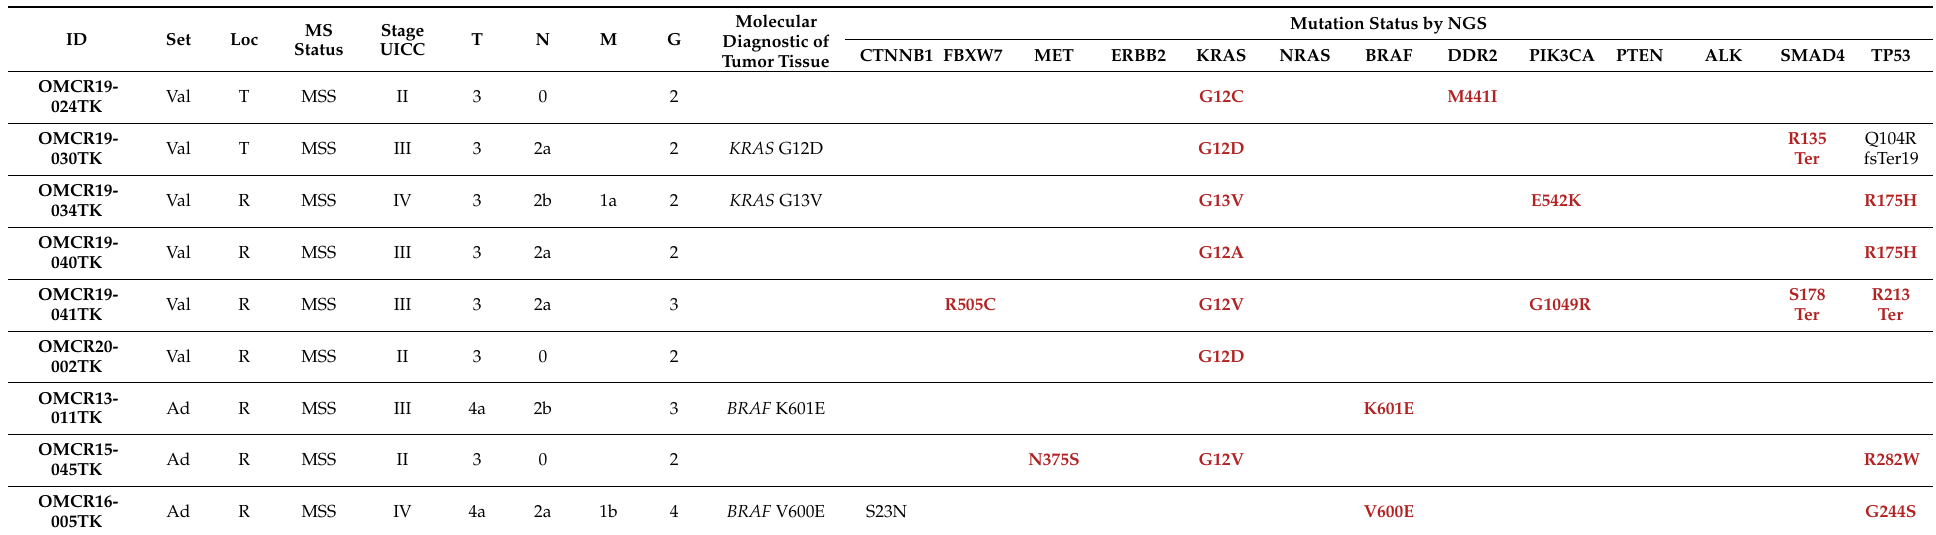
Table legend: Exp, experimental set; Val, validation set; Ad, added cases. Loc, localization of primary tumor; R, right colon; T, transverse colon; L, left colon; S, sigma; RT, rectum. MS, microsatellite; MSS, microsatellite-stable tumor; MSI, microsatellite-unstable